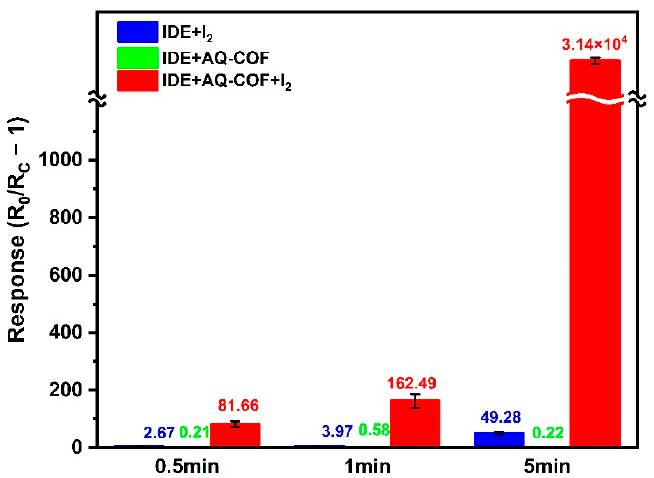
Figure 3. The response of the IDE sensors with or without AQ-COF coating at 70 °C as a function of time.